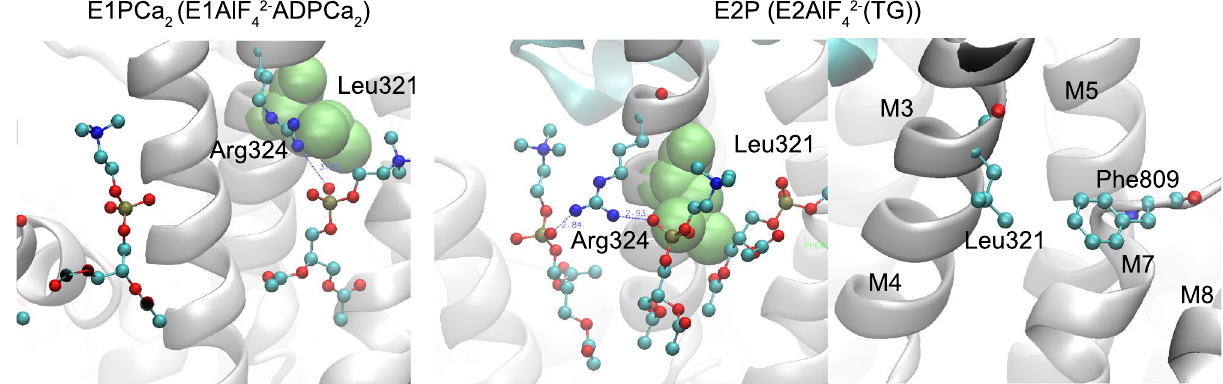
Figure 5. Location of Leu321 in crystal structures of E1PCa 2 and E2P analogs. Left and middle panels, Arg324 and its connecting phospholipids are shown in the ball and stick model and Leu321 in van der Waals spheres in E1PCa (PDB ID: 5XA8) or an E2P analog (PDB ID: 5XA9). Right panel, Leu321 and Phe809 are shown in ball and stick model in an E2P analog (PDB ID: 5XA9). The transmembrane helices M3–5, 7, and 8 are indicated in the right